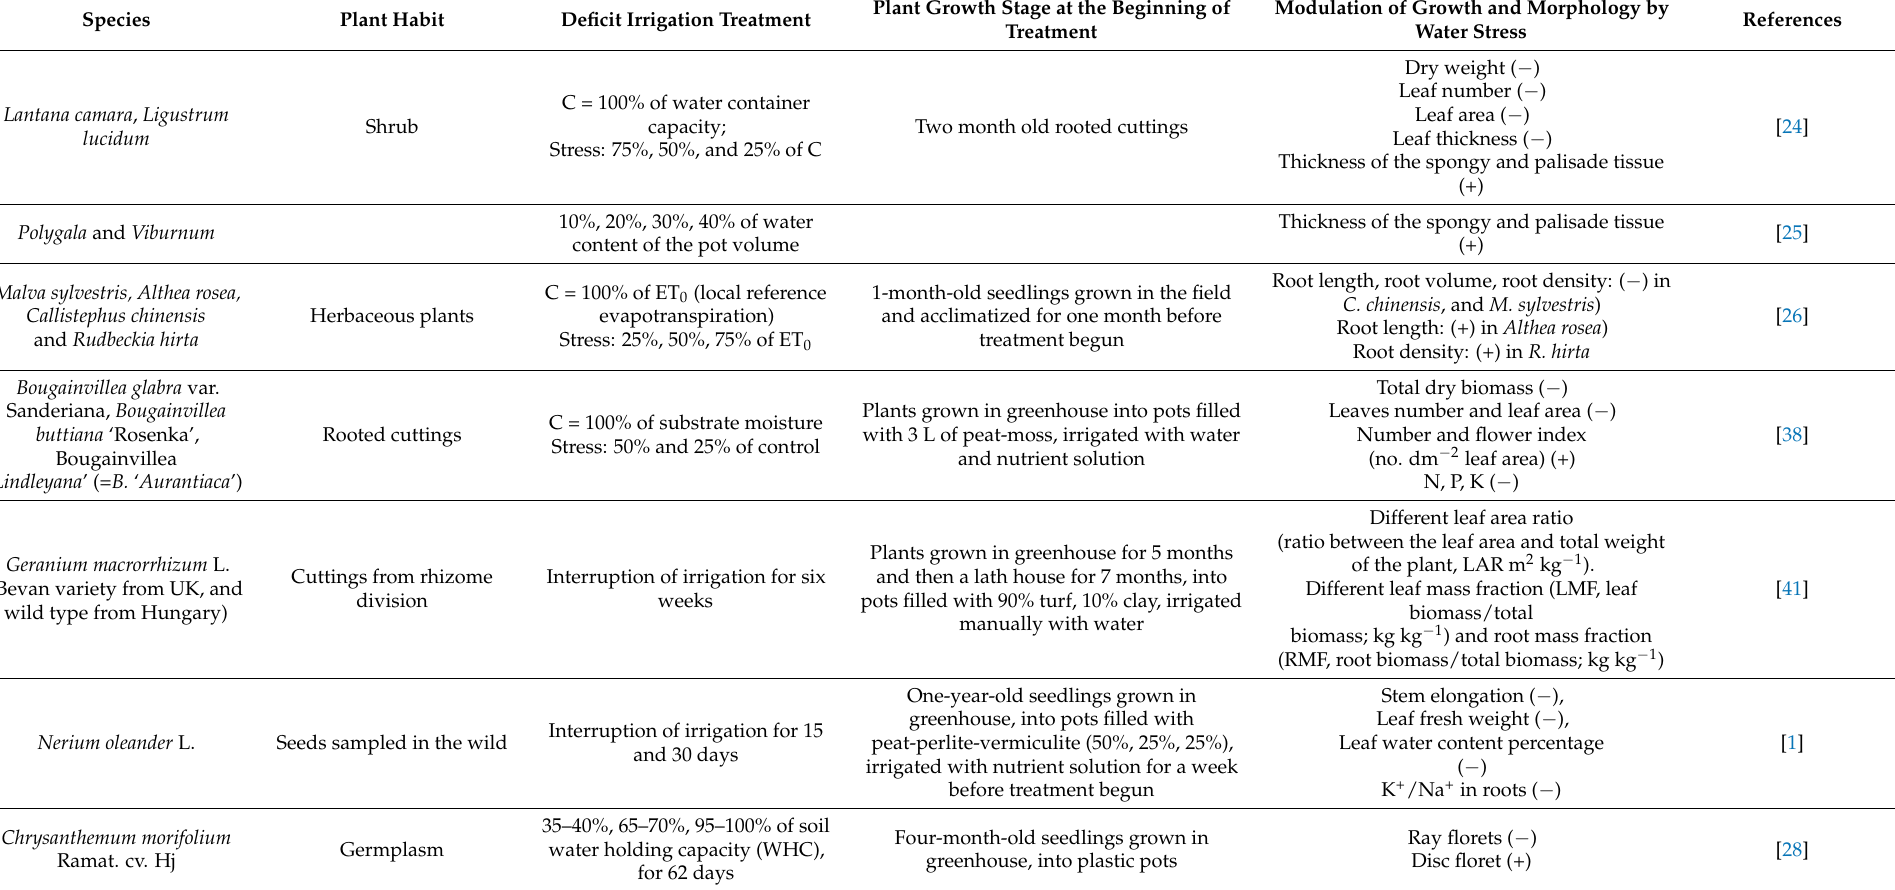
Table 1. The effect of water stress on ornamental plants growth and morphology. ( − ) reduction due to water stress and compared to the control (C); (+) increase due to water stress and compared to the